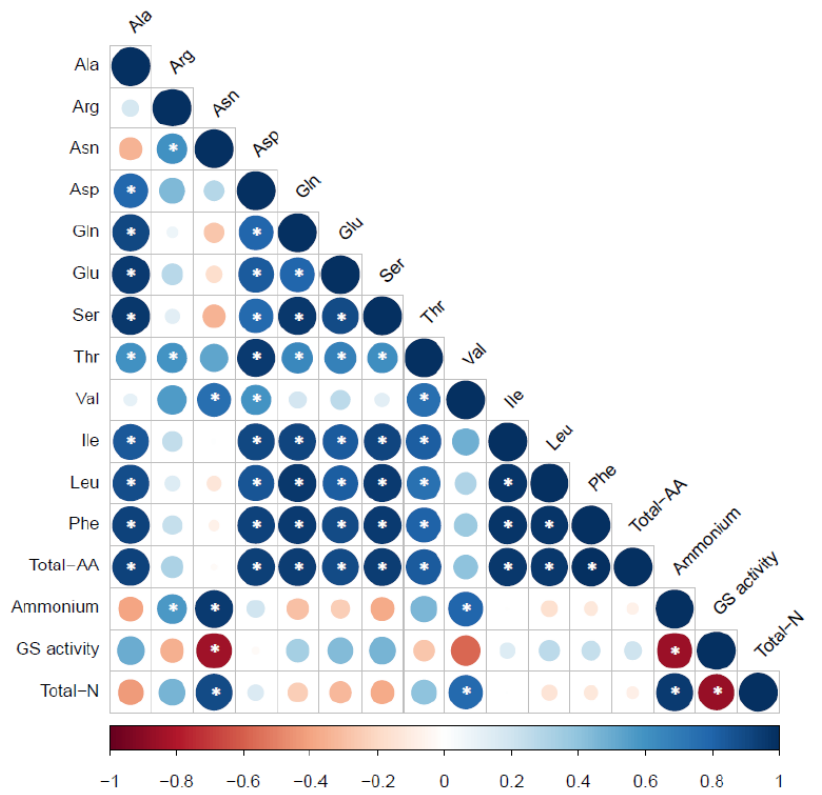
Figure 8. Pearson correlation of N parameters determined in the youngest and second youngest fully expanded leaves of spring wheat (cv. Amaretto) foliar fertilized with UAN in different N concentrations (0, 10, and 20% of N) at 6 HAFNf. * indicates significant correlation ( p < 0.05). Before the sampling of the wheat leaves, net photosynthesis, transpiration rate, and stomatal conductance were also measured in the youngest and second youngest fully ex- panded leaves of plants in the control and 20% N treatments. The latter N treatment was chosen because it was the lowest N concentration of the UAN solution which caused leaf scorching (Figure 1). Net photosynthesis (Figure 9) as well as the stomatal conductance (Figure S4) decreased in the plants following foliar fertilization with 20% N treatment al- ready at 3 HAFNf, while no difference was observed in the transpiration rate.